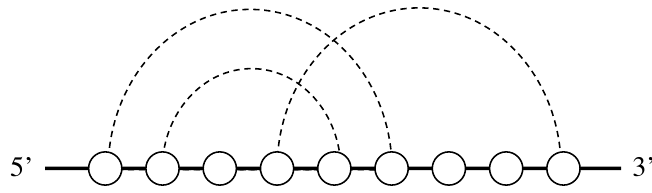
Figure 1. An example of